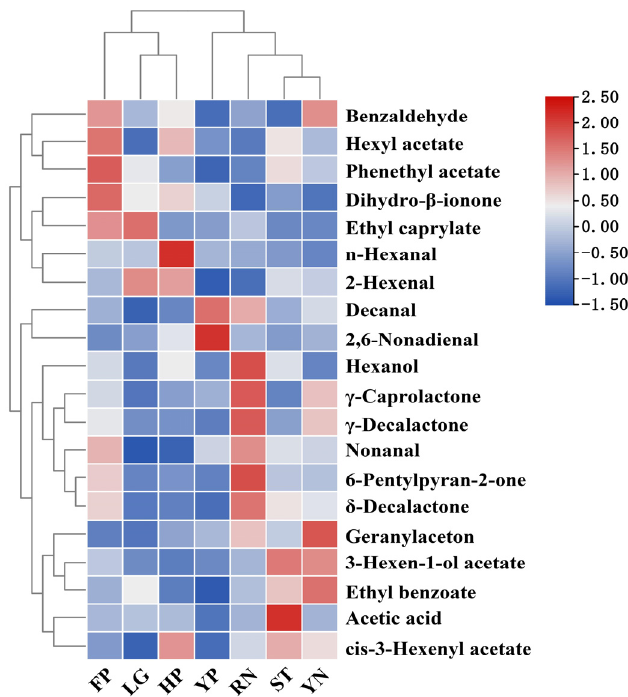
Figure 5. The heat map of the main aroma compounds in seven peach cultivars. The OAVs of the main aroma compounds in flat peach (FP), liguang peach (LG), honey peach (HP), yellow peach (YP), yellow nectarine (YN), red nectarine (RN) and shoutao (ST) from shihezi, Xinjiang.